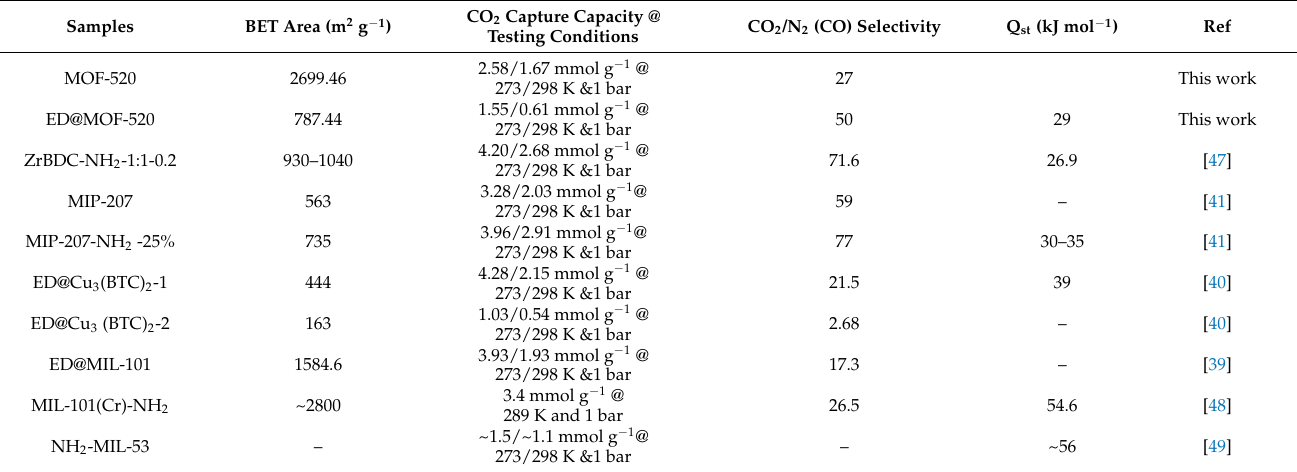
Table 2. The comparison of BET area and CO 2 capture performance in this work and reported amine-functionalized